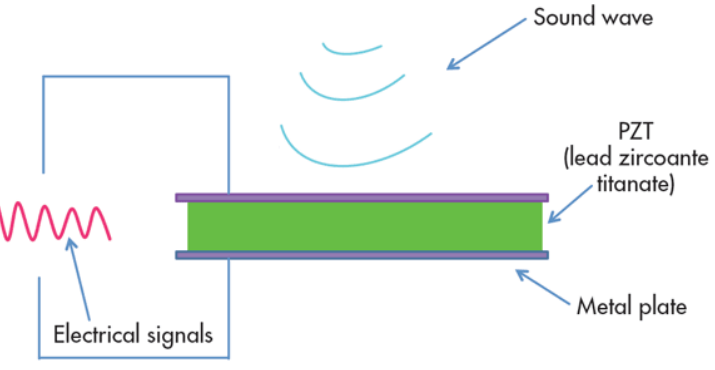
Figure 3. Concept of